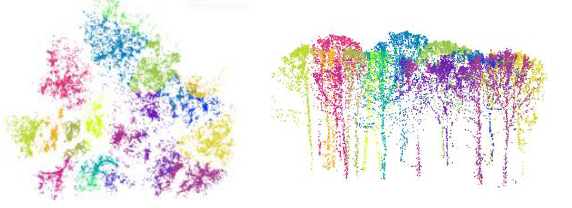
Figure 3. Top and the front of Plot C segmented using Method 3 (calibrated), with each separate tree assigned a random colour. peak. Parameter calibration help to significantly reduce the number of overdetected trees, but did not improve the recall. Underdetection in plot C is mot likely due to some overlap between the crowns. Method 5 achieved the best accuracy in both tests, but its performance after calibration did not increase significantly. 3.4 Plot D: Sitka spruce ( Picea sitchensis ) Due to the presence of foliage, only very small number of trunk points could be retrieved, not sufficient to significantly aid tree detection (Figure 4). In both tests, Method 4 achieves the best result (F-score=0.842 and F-score=0.927). Method 5 notes the poorest performance from all the algorithms in Test 2, but improves significantly after parameter calibration (from F- score=0.750 to